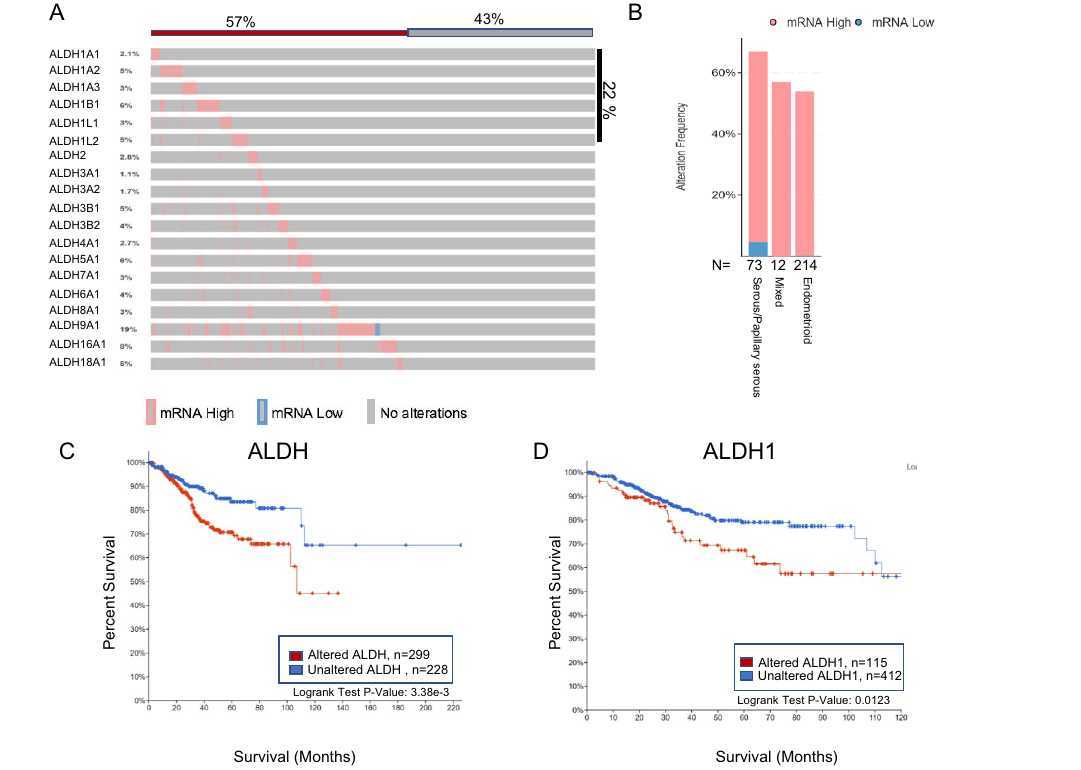
Figure 1. ( A ) ALDH expression was evaluated in the PanCancer Atlas. An OncoPrint depicts the results and shows the graphical summary of mRNA alternations in all 19 ALDH isoforms across a set of 527 endometrial tumor samples (TCGA, PanCancer Atlas). ( B ) Distribution of ALDH isoforms in serous/papillary, mixed or endometrioid endometrial cancer. ( C ) Kaplan–Meier plot showing overall survival of Endometrial Carcinoma patients from the TCGA database with altered (red, number of patients, n = 299) or unaltered ALDH expression (blue, number of patients, n = 228). The Two-sided log-rank P value is displayed. ( C ) Kaplan–Meier plot showing overall survival of Endometrial Carcinoma patients from the TCGA database with altered (red; number of patients, n = 115) or unaltered ALDH1 expression (blue, number of patients, n = 412). A two-sided log-rank P value is